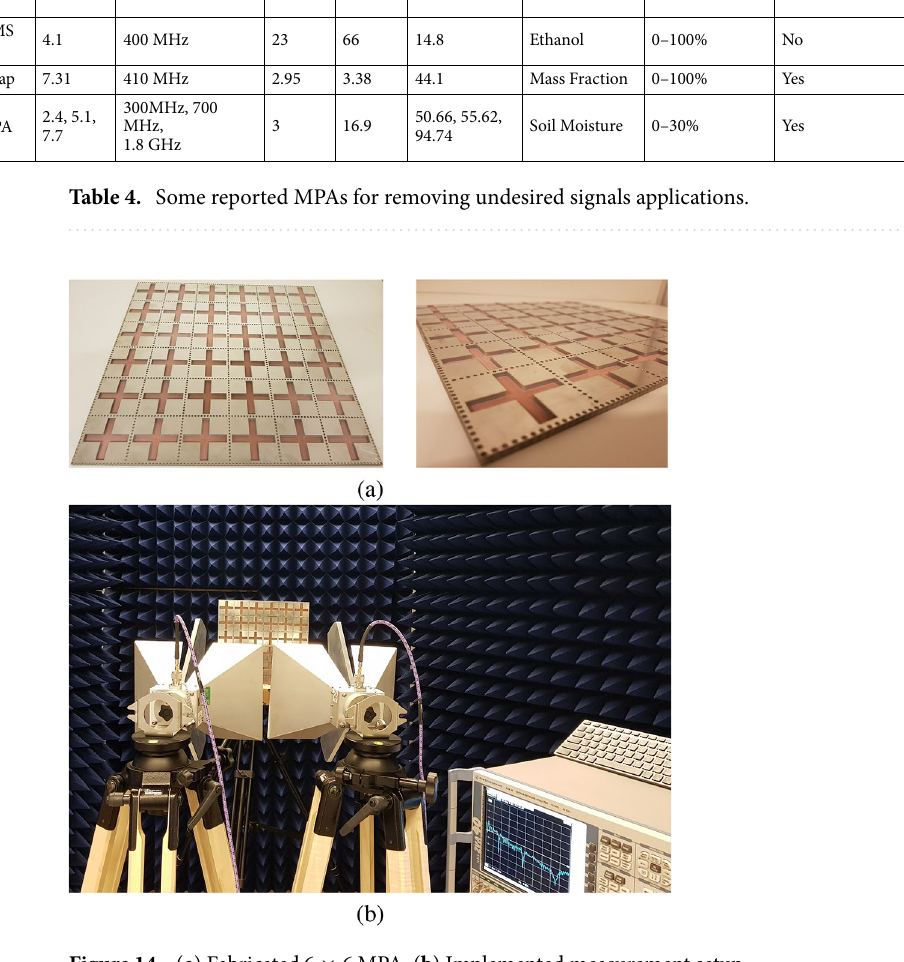
Figure 14. ( a ) Fabricated 6